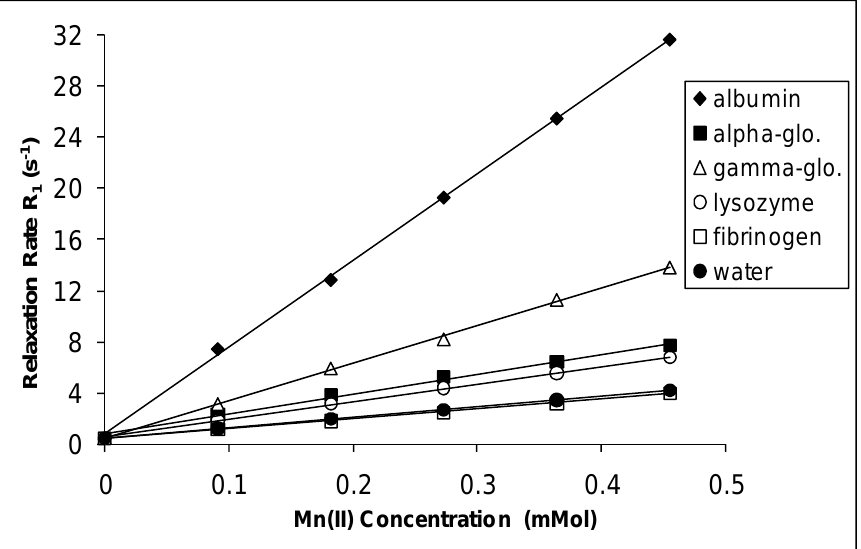
) of protein solutions versus concentration of 1